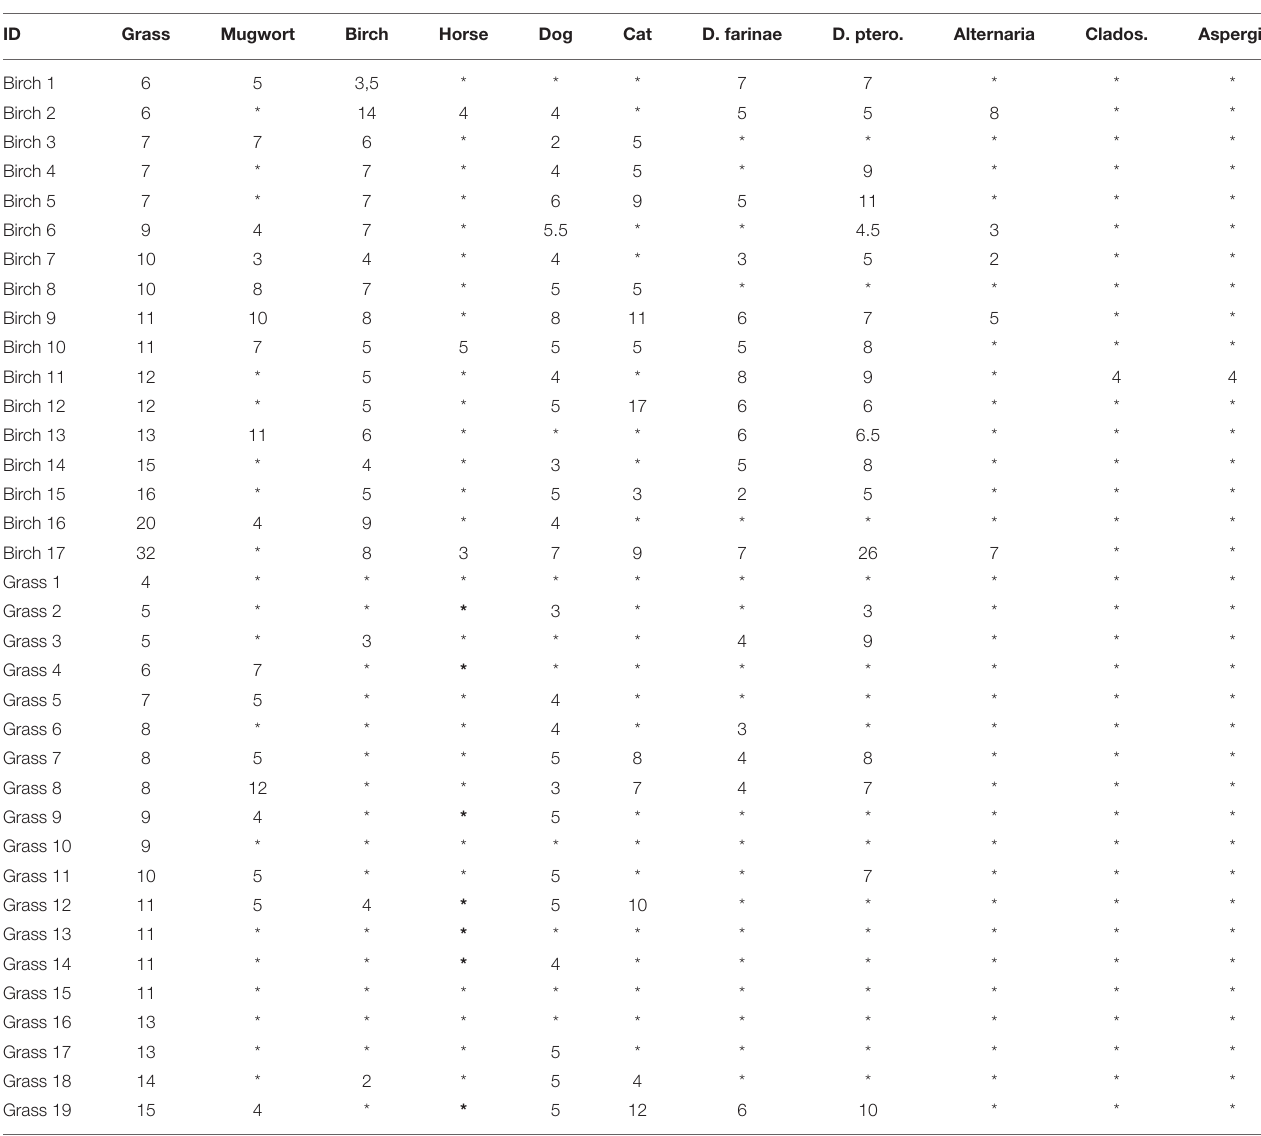
TABLE A1 | Sensitization profiles for all study